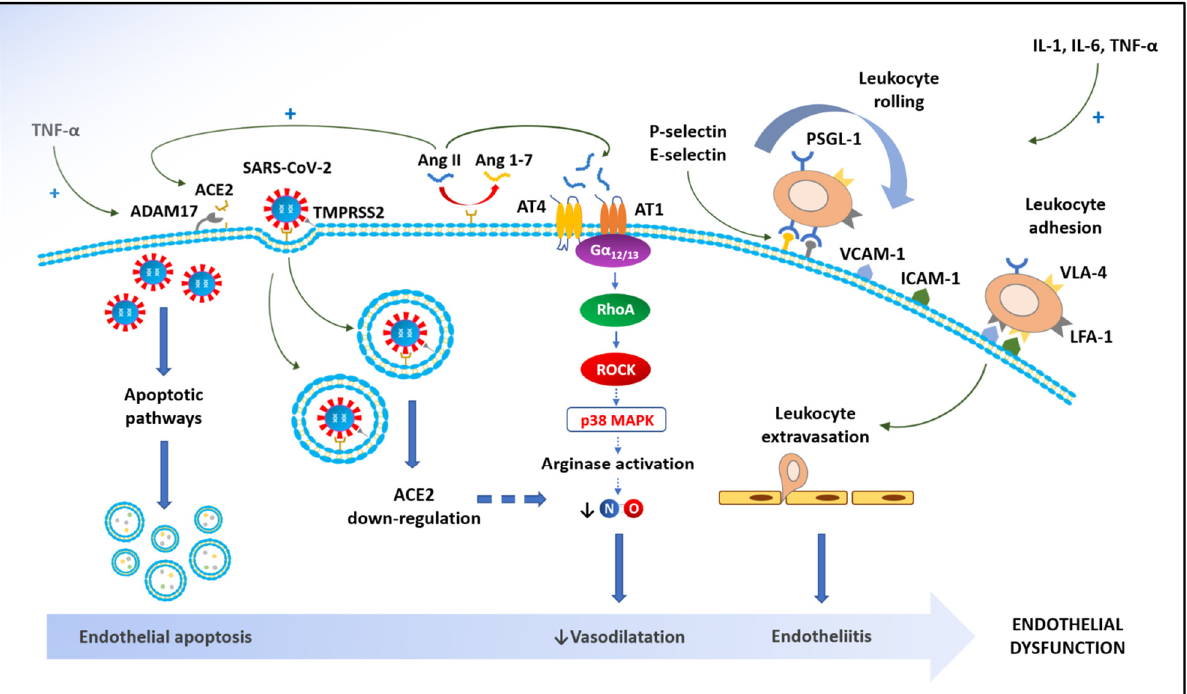
Figure 2. Physiopathology of endothelial dysfunction in coronavirus disease 2019 (COVID-19). SARS-CoV-2: severe acute respiratory syndrome coronavirus 2; TNF- α : tumor necrosis factor alpha; ADAM17: a disintegrin and metalloprotease 17; ACE2: angiotensin-converting enzyme 2; Ang II: